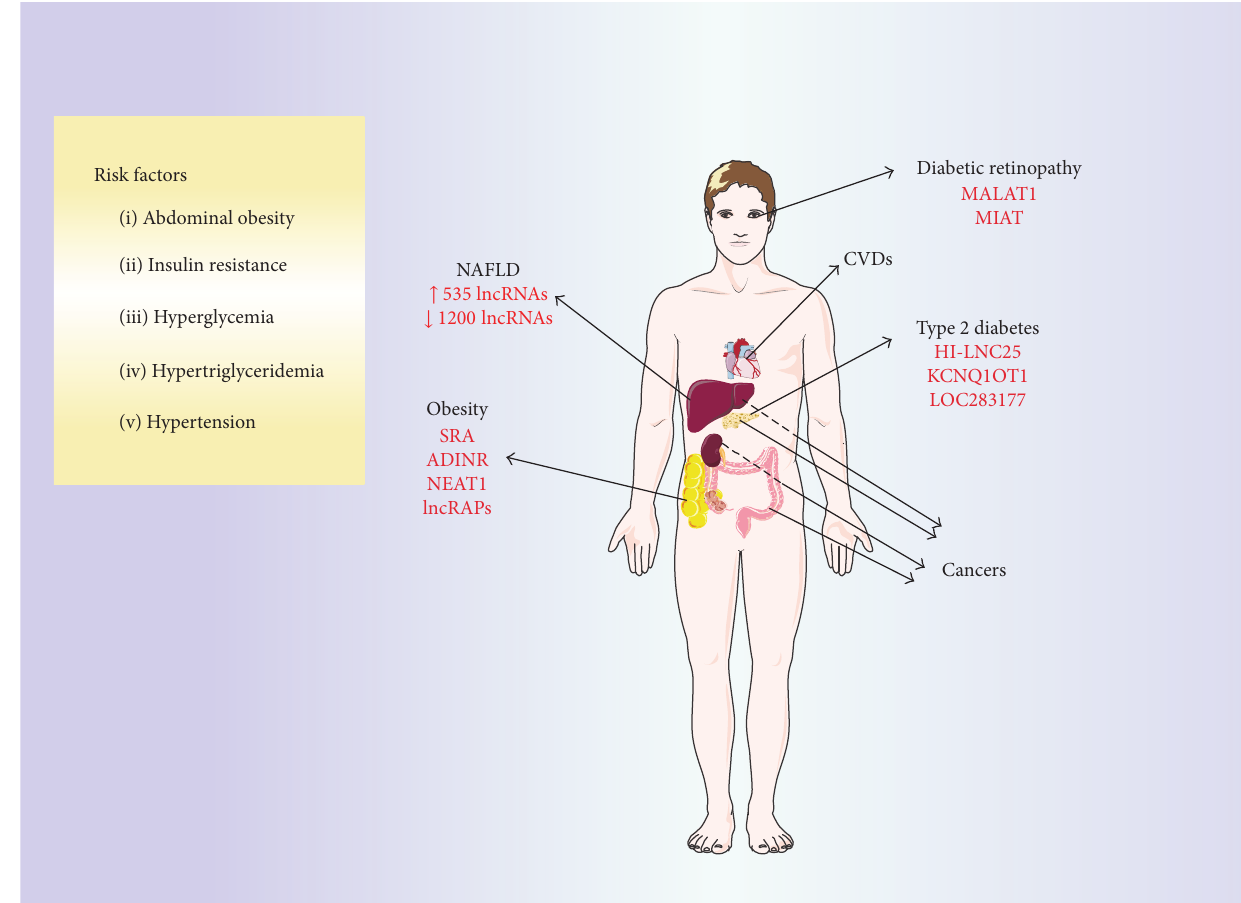
Figure 5: Development of metabolic syndrome. The common clinical symptoms of metabolic disorders include abdominal obesity, insulin resistance, hyperglycemia, hypertriglyceridemia, and hypertension [15]. Their appearance is associated with a high risk for development of serious diseases including type 2 diabetes, diabetes-related diabetic retinopathy [16], and nonalcoholic fatty liver disease (NAFLD) [17], as well as cardiovascular diseases (CVDs) [18] and even some cancers including liver, pancreas, and colon [19] (CVDs and cancers are not discussed in this review). Selected lncRNAs involved in the control of metabolic system activity (e.g., adipogenesis: SRA, ADINR, NEAT1, and lncRAPs) and pathology of metabolic diseases (e.g., type 2 diabetes, HI-LNC25, KCNQ1OT1, LOC283177, diabetic retinopathy, MALAT1, and MIAT) are marked with the red color. In NAFLD, 535 lncRNAs are upregulated and 1,200 are downregulated; however, these sequences are not yet well characterized [20]. This figure was produced using modified elements from the Servier Medical Art